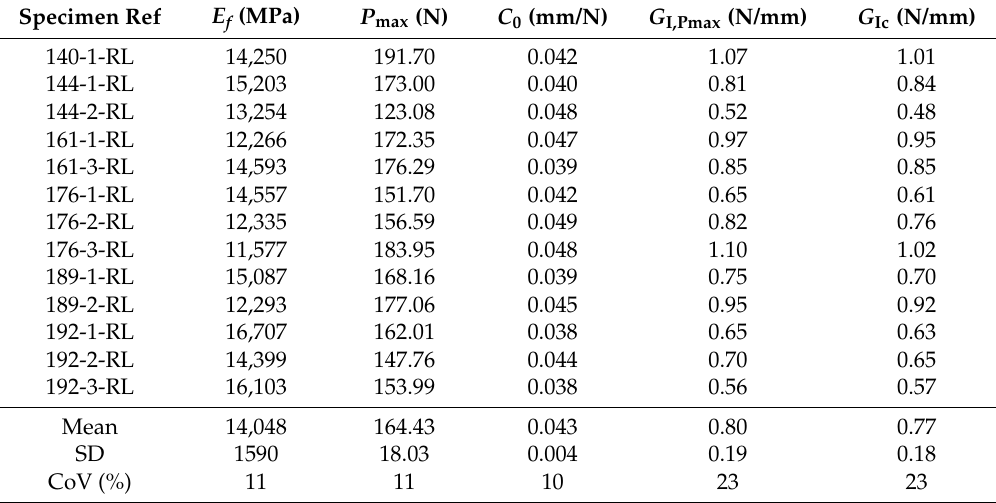
Table 3. Fracture energy obtained from DCB specimens oriented in RL by means of Compliance-Based Beam Method (CBBM).